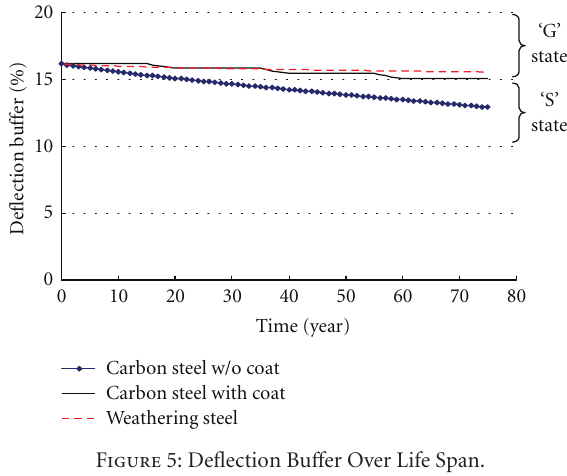
Figure 5: Deflection Bu ff er Over Life Span.